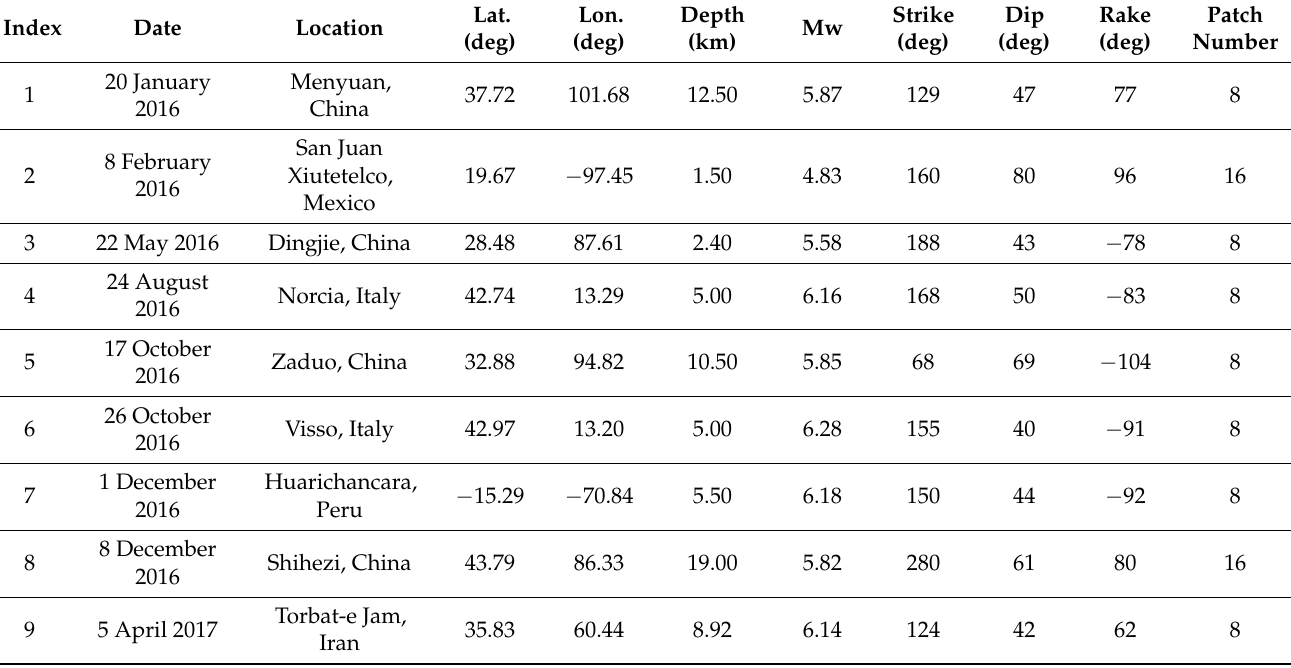
Table 1. Information of earthquakes (Mw ≤ 6.5) tested in this